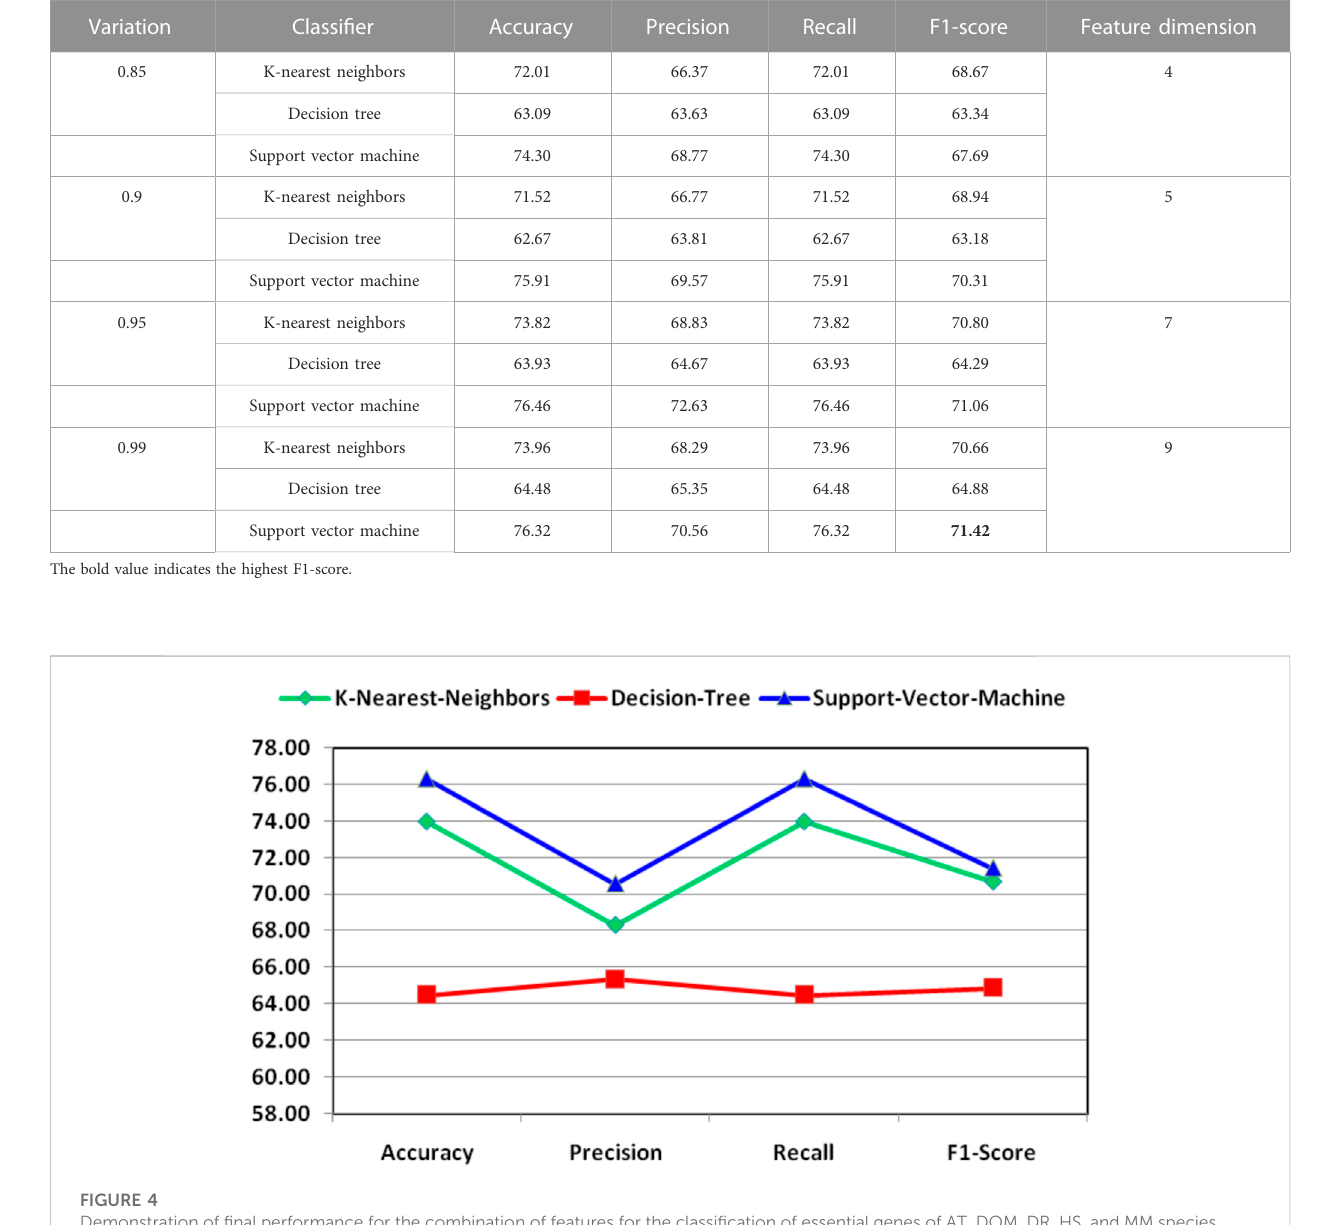
FIGURE 4 Demonstration of fi nal performance for the combination of features for the classi fi cation of essential genes of AT, DOM, DR, HS, and MM species.